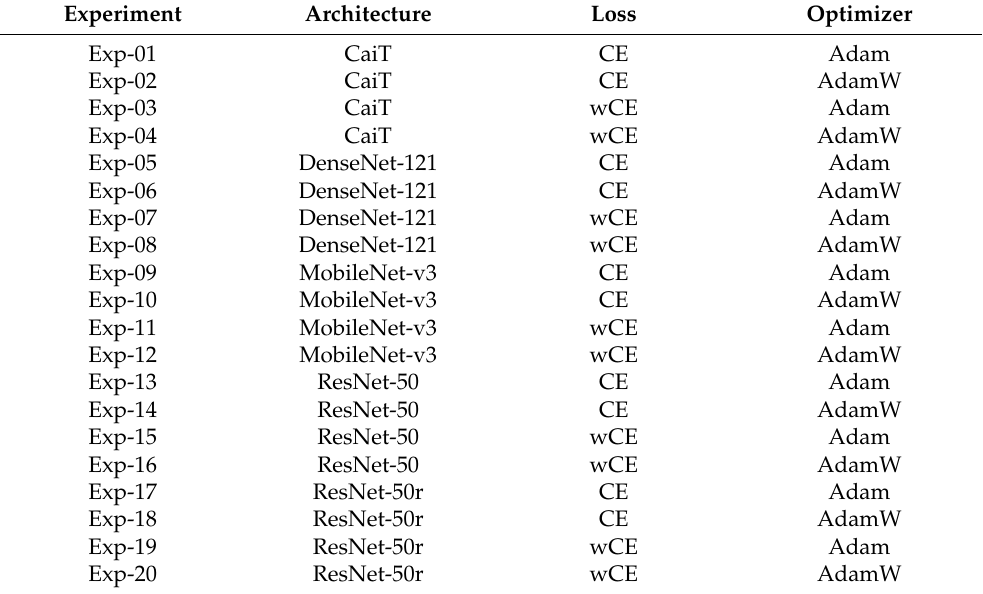
Table 3. Experimental design for the comparison of deep learning networks for the classification of COVID-19 in a multi-class setup. All experiments were trained in batches of 8 images, for 8 epochs and learning rate of 0.00002. CaiT: CaiT-24-XXS-224, MobileNet-v3: MobileNet-v3-large. ResNet50r: ResNet-50 with the first kernel resized from 7 × 7 to 5 × 5. CE: Cross Entropy, wCE: weighted Cross Entropy.